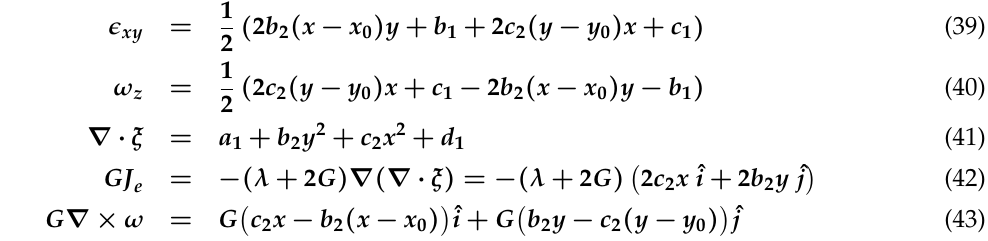
Figure 4. Basic types of v fringes. ( A – E ) are typical patterns obsered in tensile experiment with ESPI. With expressions (37) and (38), the shear strain (13) and rotation (14) in the xy -plain, the volume expansion ∇ · ξ , the longitudinal elastic force (24) and transverse elastic force (9) can be written as follows.